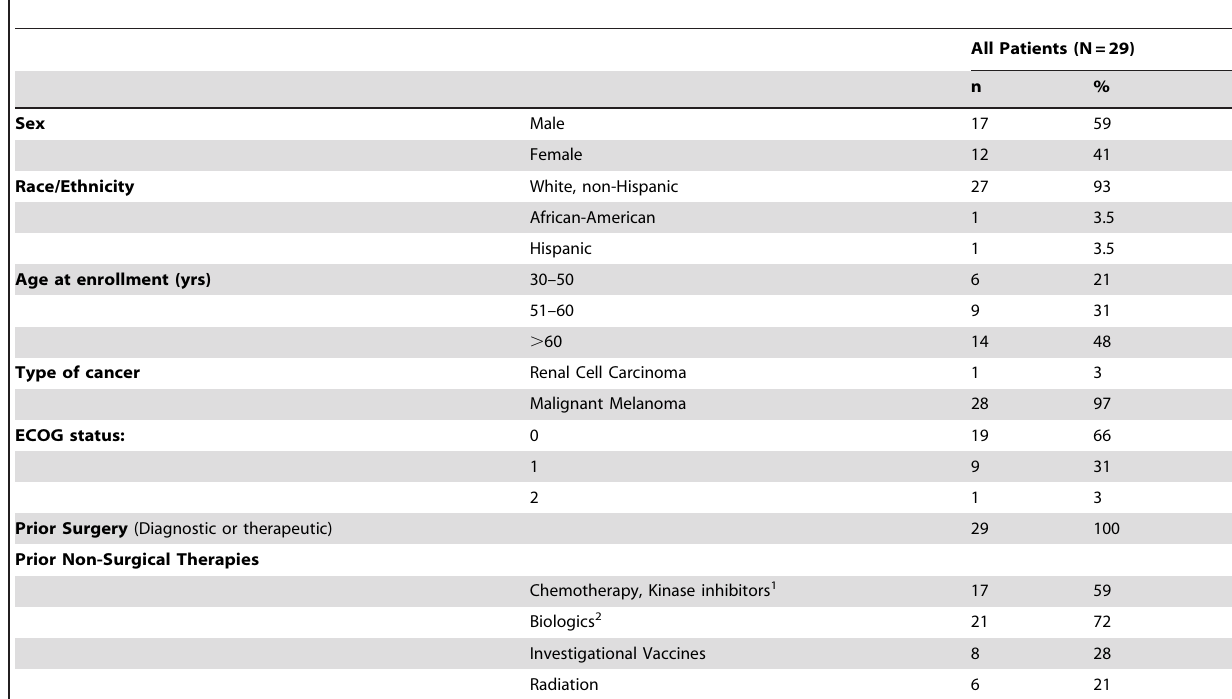
Table 1. Patient